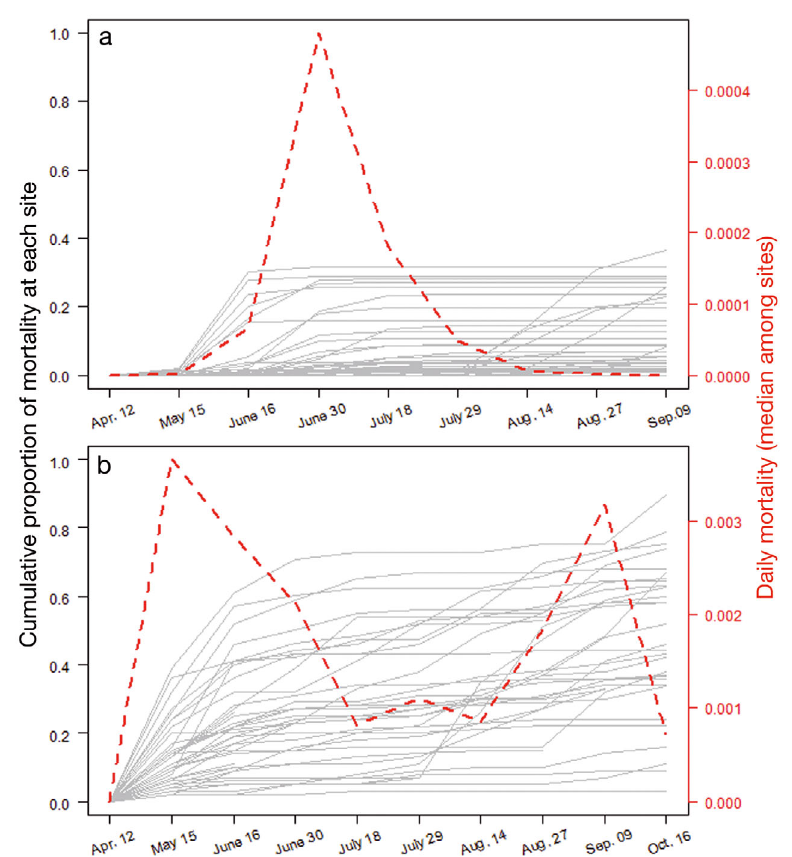
Fig. 2. Cumulative mortality as a function of time for (a) young and (b) adult Pacific oysters for each site (grey solid lines) and median daily mortality among all sites (red dashed lines). For young oysters, smoothed data are